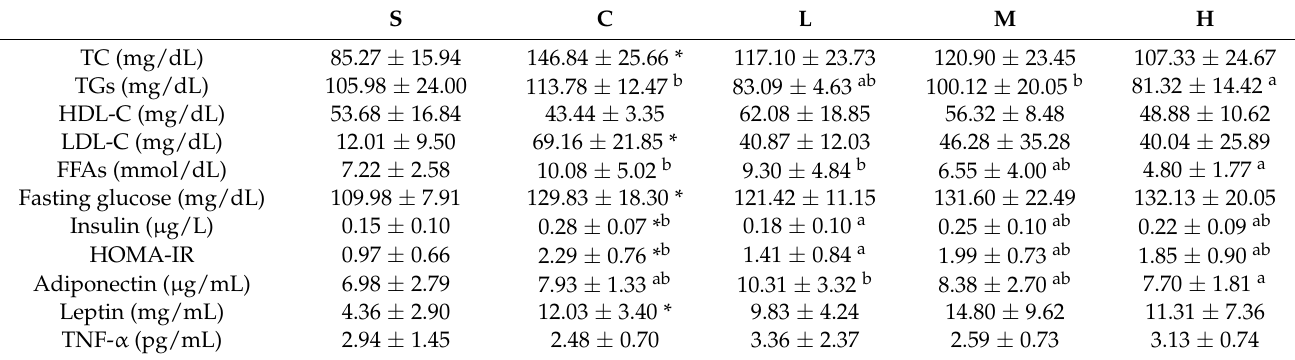
Table 7. Serum lipid variables, glucose and TNF- α after an ovariectomy and 8 weeks of a dietary